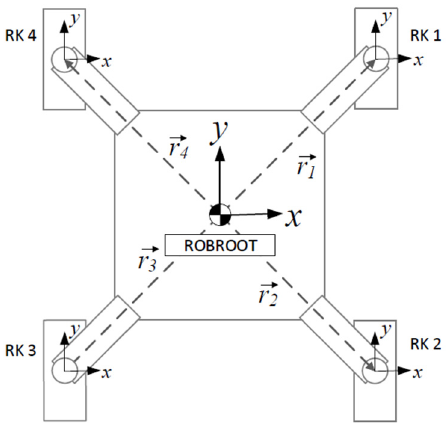
Figure 19. Robot coordinate frames.